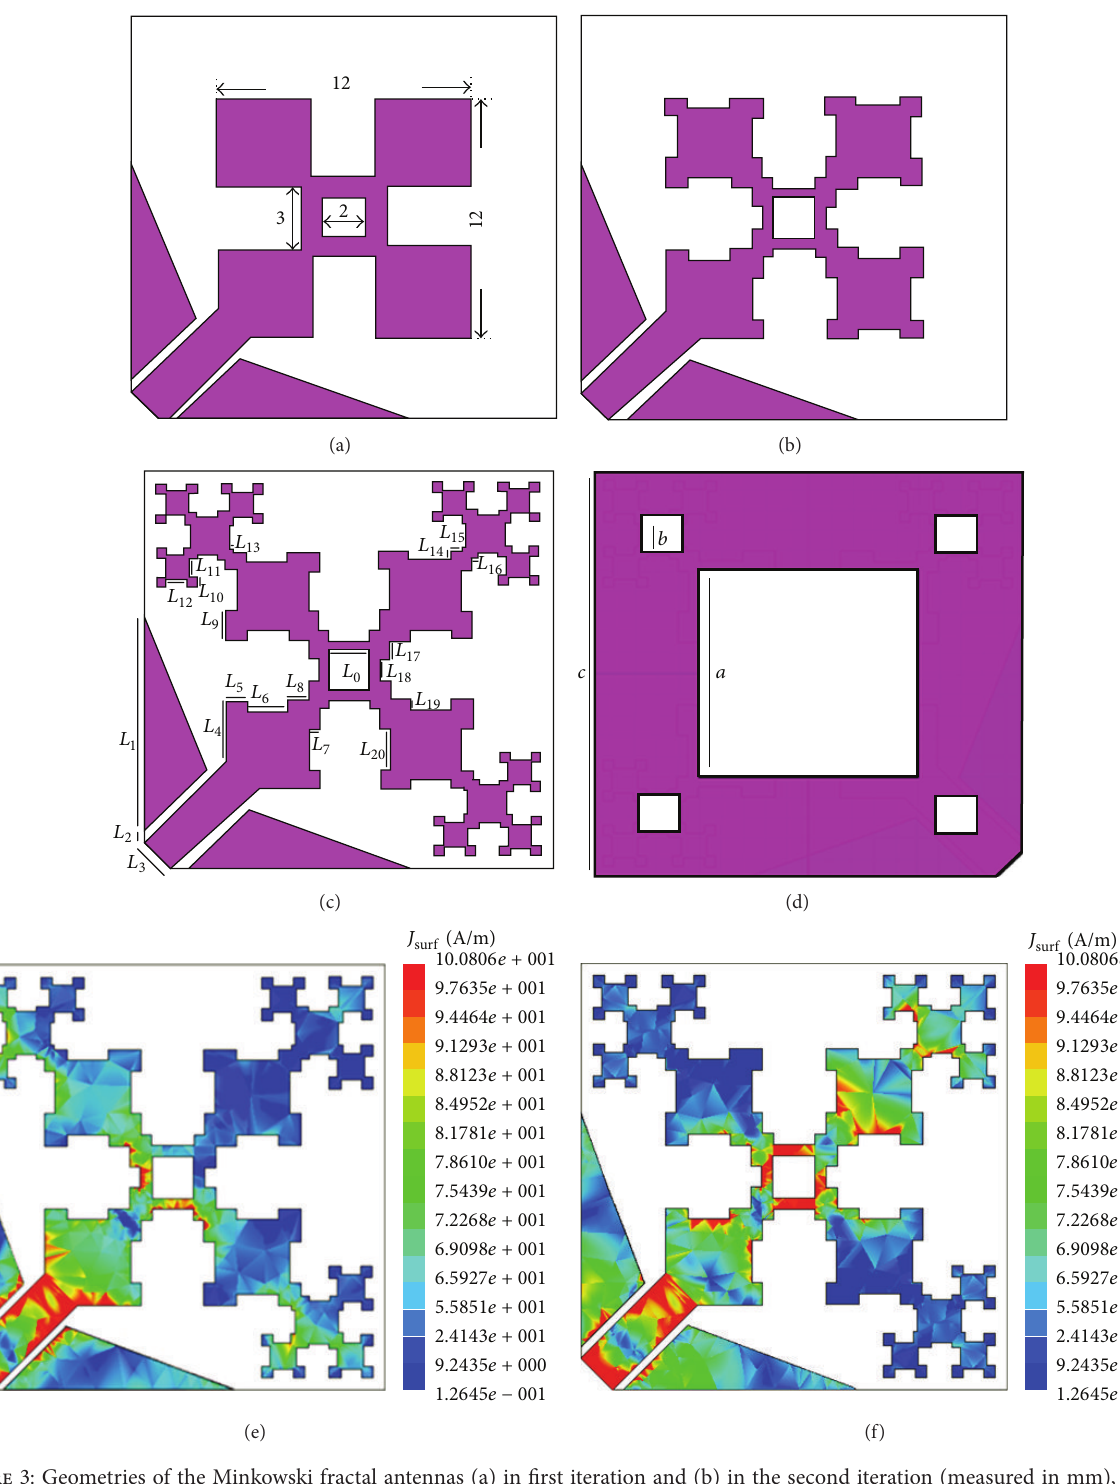
Figure 3: Geometries of the Minkowski fractal antennas (a) in first iteration and (b) in the second iteration (measured in mm), and the geometryoftheoptimizedMinkowskifractalantennashownon(c)toplayerand(d)bottomlayer.Thedesignedantenna’scurrentdistribution at (e) 2.4 GHz and (f) 5.8